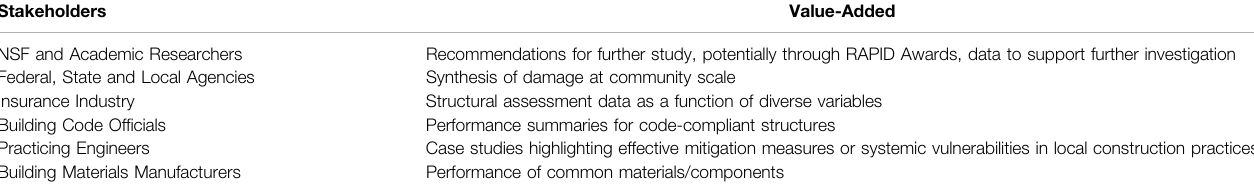
TABLE 5 | StEER products value-added for different stakeholder groups.